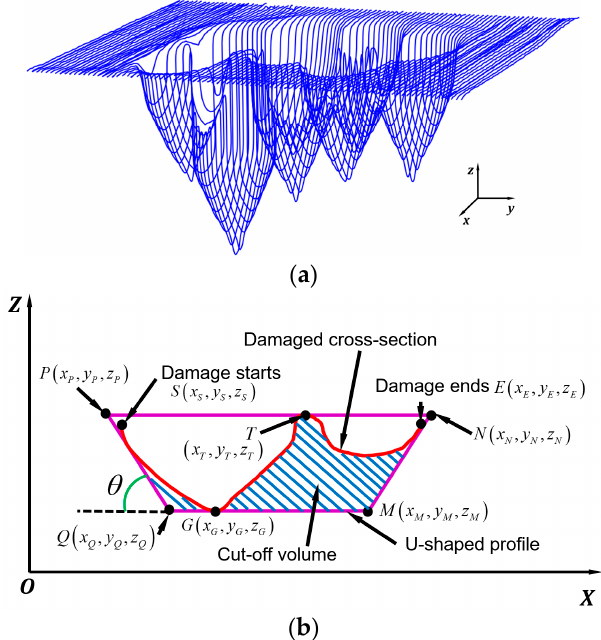
Figure 6. ( a ) Cross-sections of the block; ( b ) U-shaped boundary (UB) definition.